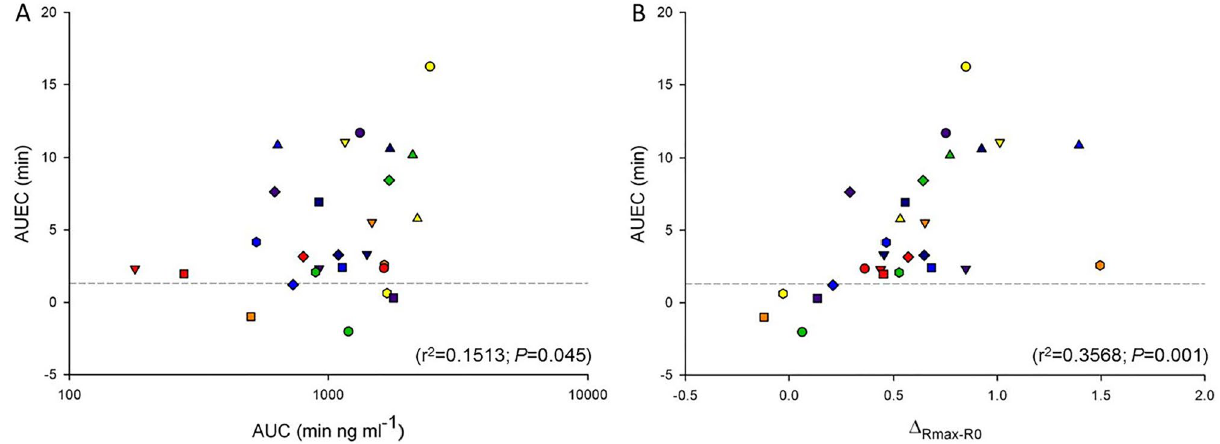
Figure 5. Relationship between AUEC and AUC ( A ) and relationship between AUEC and ∆ Rmax-R0 ( B ) for the inhalation period (10–30 min) using linear regression models (n = 27). AUC area under the plasma concentration–time curve, AUEC area under the effect-time curve, ∆ Rmax-R0 magnitude of peak